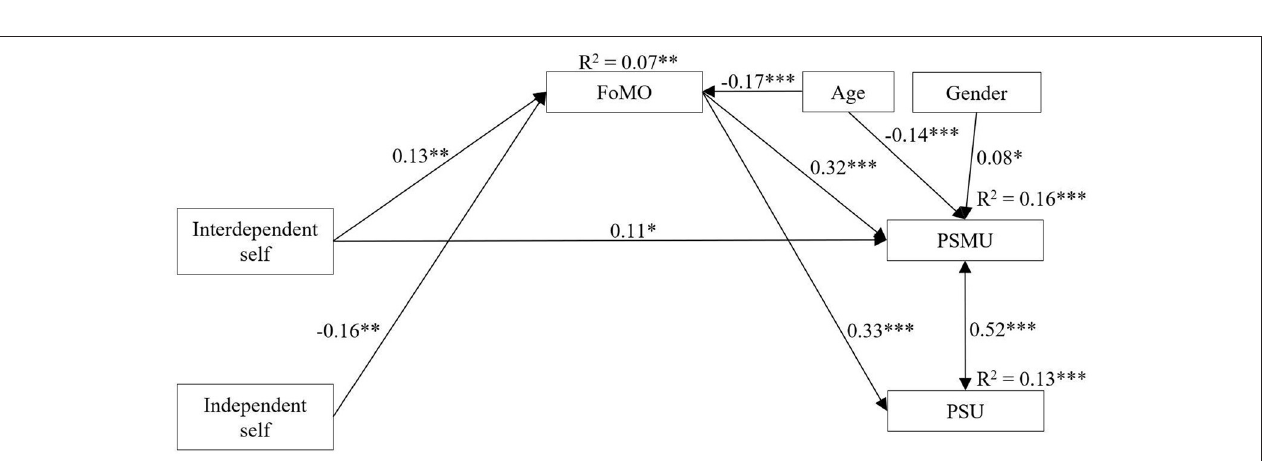
Frontiers in Public Health |